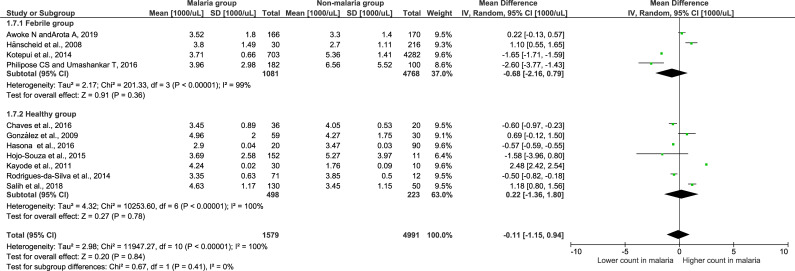
Forest plot of the neutrophil count among included studies.Forest plot showing the neutrophil count in the malaria and non-malaria groups. [1000/μL] refers to 1000 per microliter; “IV" in "IV, Random” refers to Inverse variance; "Total" in top row refers to number of patients included; A green square in the horizontal line refers to the mean difference for each of included study.